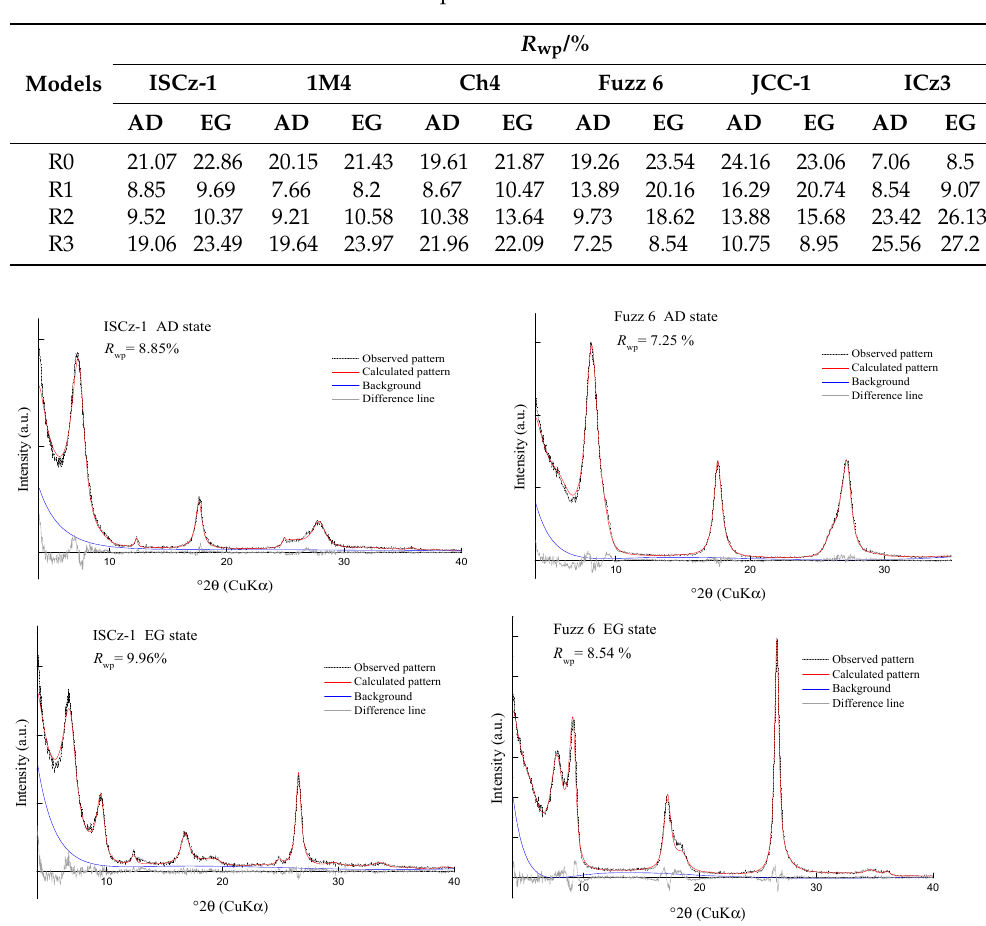
Table 6. Refinement results of oriented samples with different structure models.